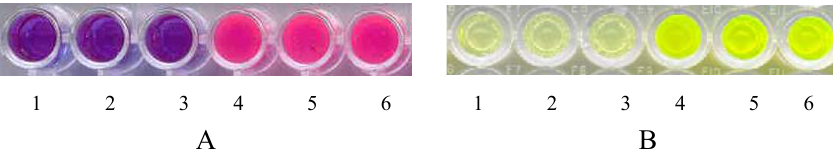
Figure 1 : Resazurin (A) and FDA (B) assay examples of the activity of compounds on the growth of